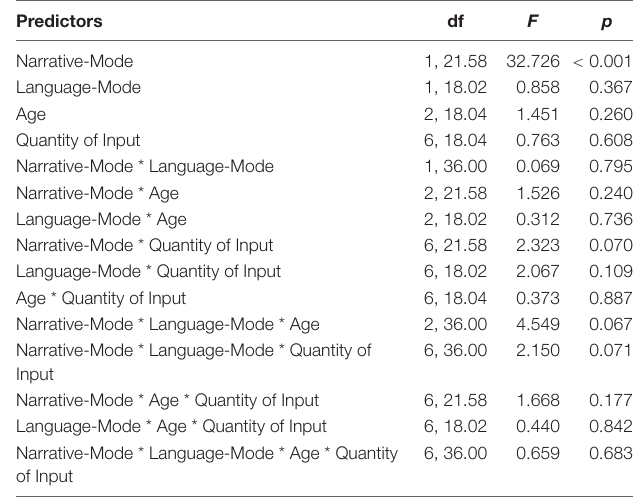
TABLE 8 | Results of the linear mixed model for the dependent variable